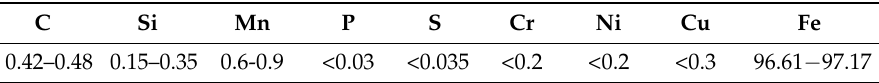
Table 1. Chemical composition of the steel substrate (wt